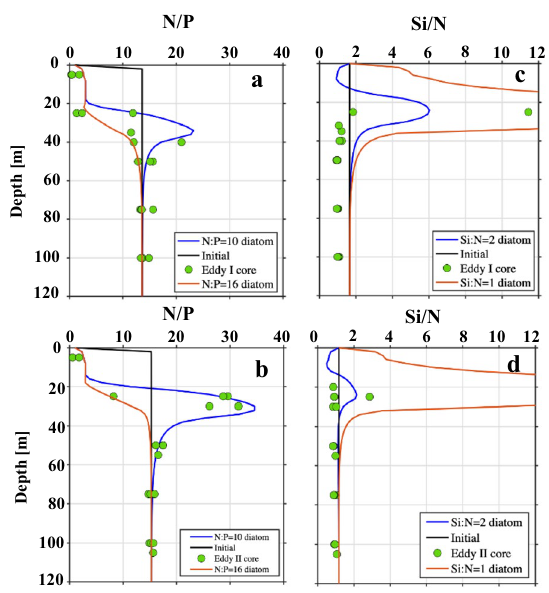
Fig. 4 Model‑derived vertical N/P ratios (a, b) and Si/N ratios (c, d) in decay eddy and mature eddy by assuming a diatom uptake N/P ratio of 16 (orange line) and 10 (blue line) and Si/N ratio of 2 (blue line) and 1 (green line), respectively. Here, the uptake N/P ratios for non‑diatoms are arbitrarily set as 16. The green dots are the in situ N/P and Si/N ratios in both C1 and C2 cores; the black line shows the N/P and Si/N profiles controlled only by physical upwelling and